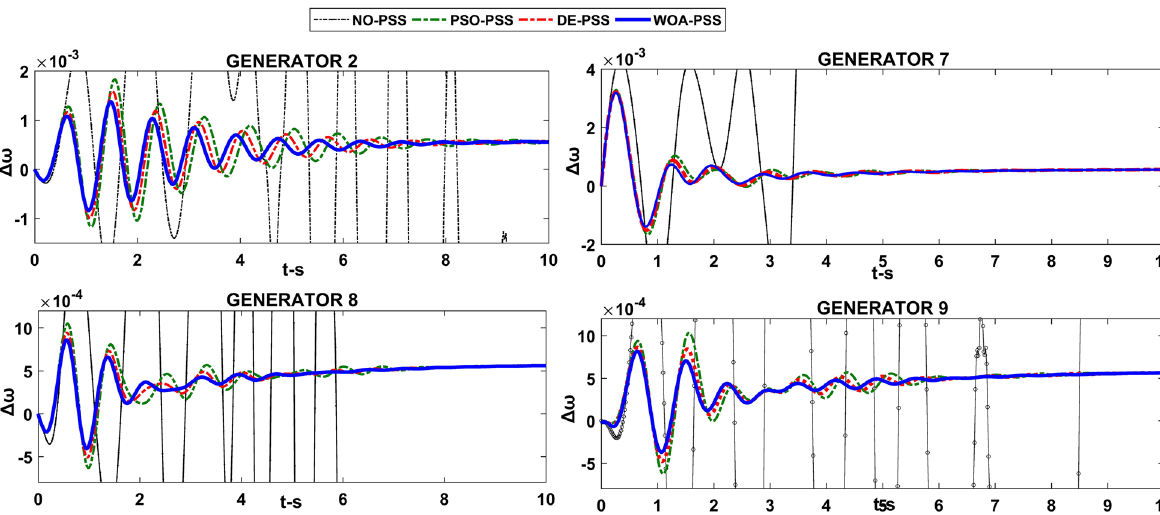
Fig. 13 Speed deviation plots under the disturbance of 25% increase in loads at buses 16 and 21, 25% increase in generation of G7, and the line outage between 21 and